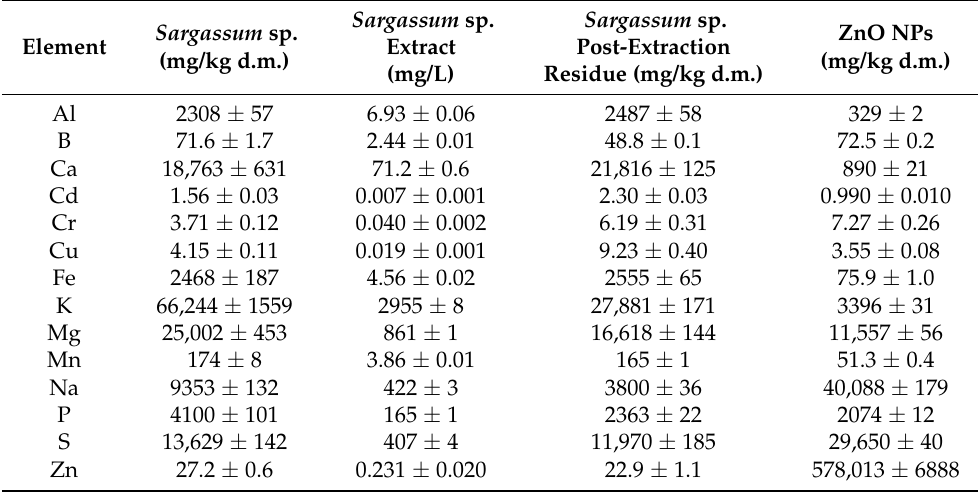
Table 3. Calculated parameters of kinetic models for the tested sorbents under conditions C 0 300 mg/L, C S 1.0 g/L, and pH 5.0. Model Sargassum sp. Pseudo-first- order